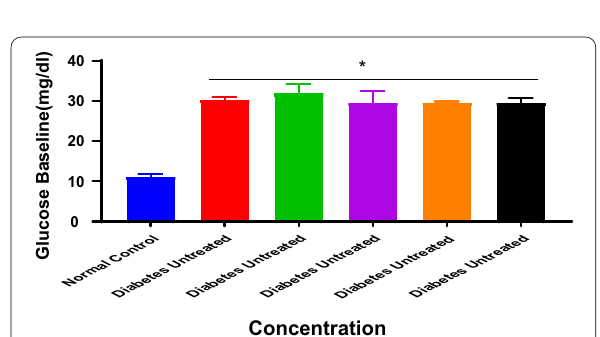
Figure 2 glucose concentration measured after the induction of diabetes significantly ( p < 0.05)